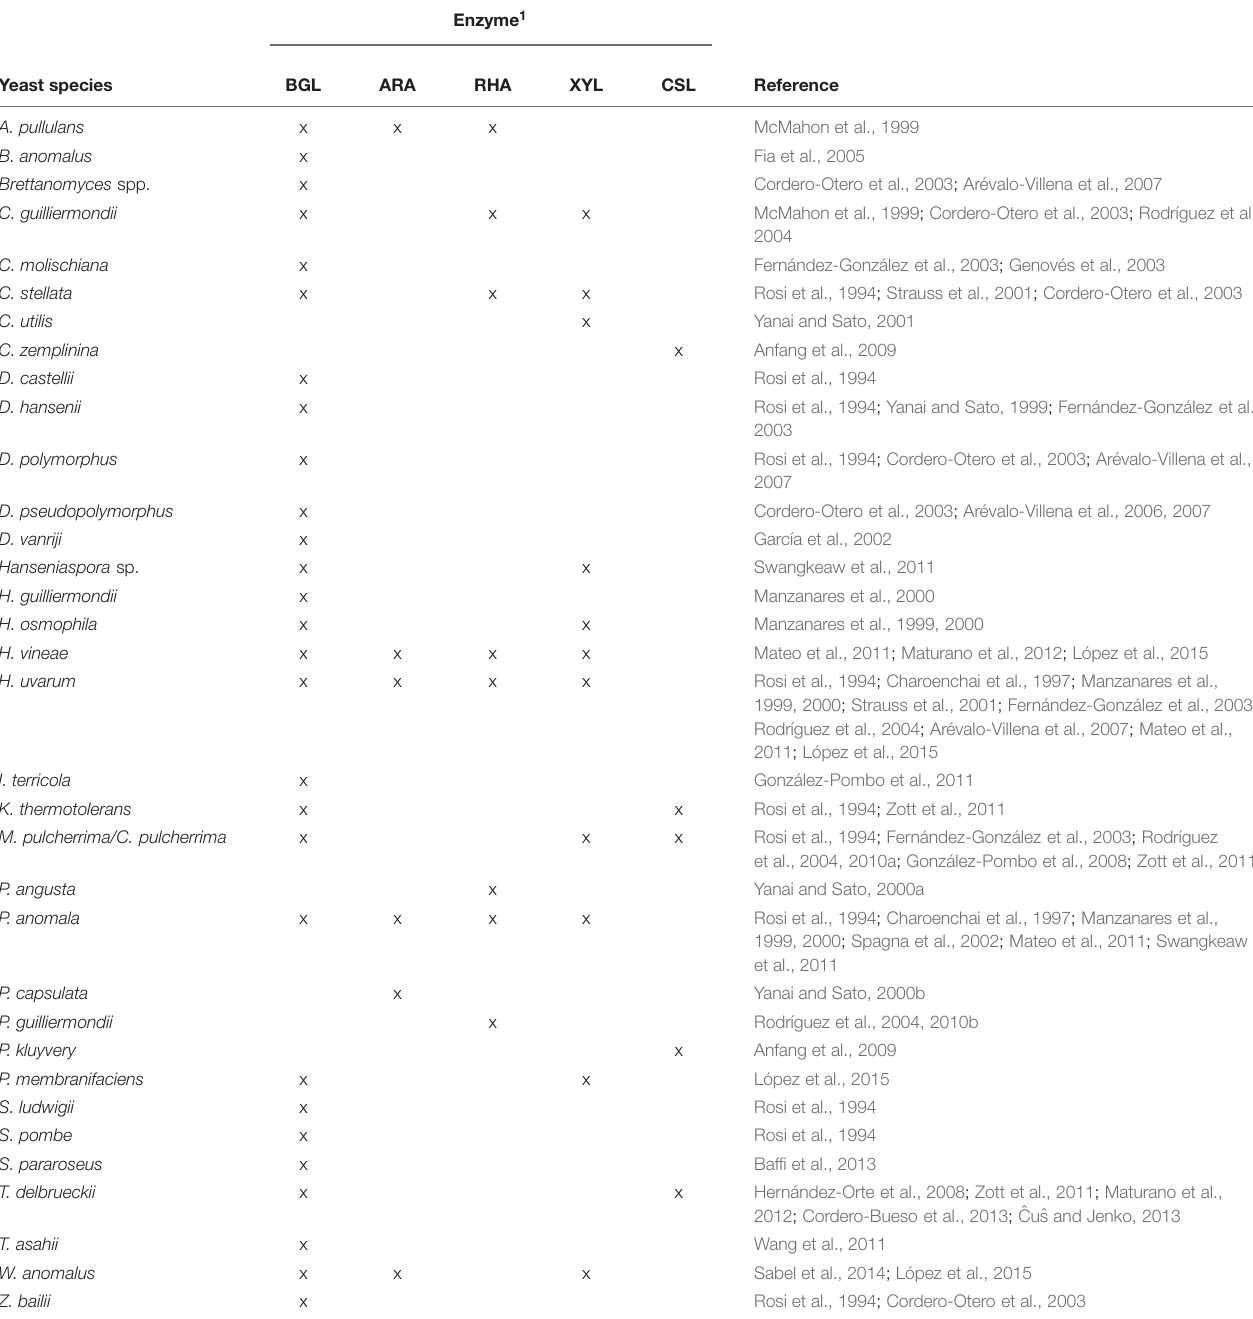
TABLE 1 | Non- Saccharomyces yeast species described as producers of enzymes involved in the release of aroma compounds from grape